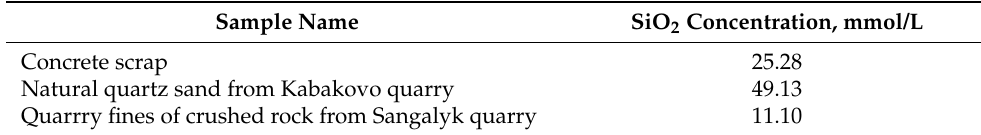
Table 7. Content of soluble silicon dioxide in the test